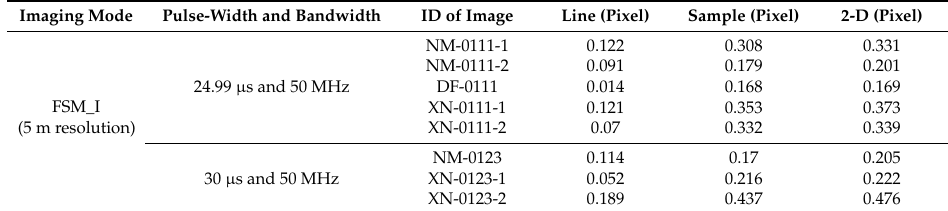
Table 3. Verification of geometric accuracy after single scene calibration.